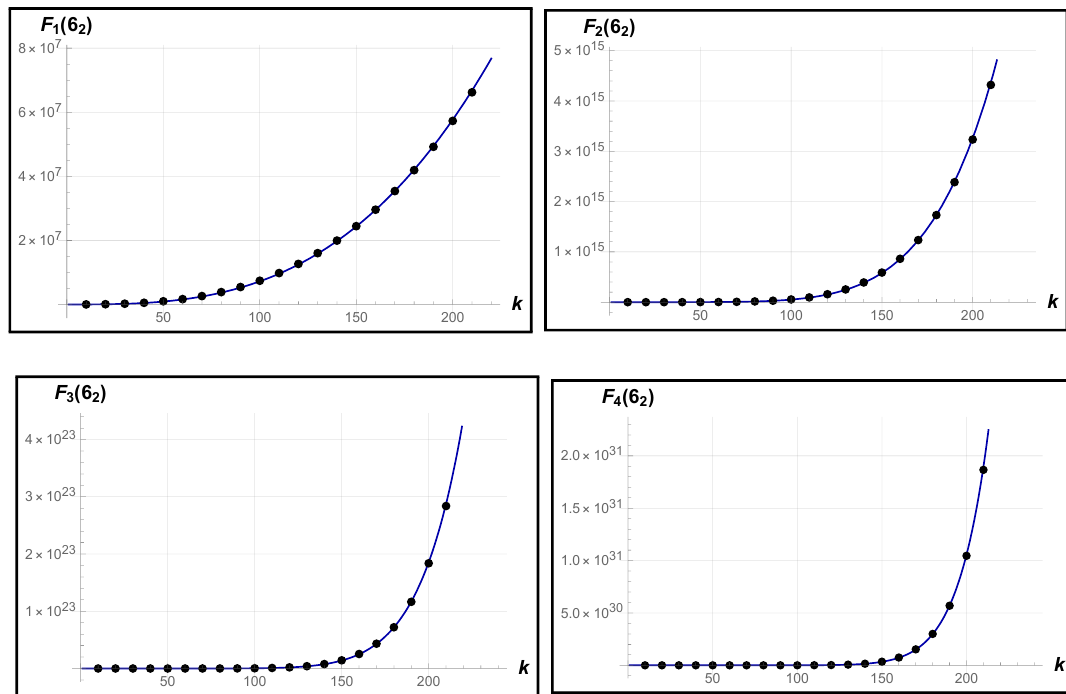
Figure 20. The variation of the function F m with k for 6 2 knot. The solid line denotes the function C m k 3 m with values of C m given in table 12. The • indicates the numerical values of F m obtained from explicit computations.